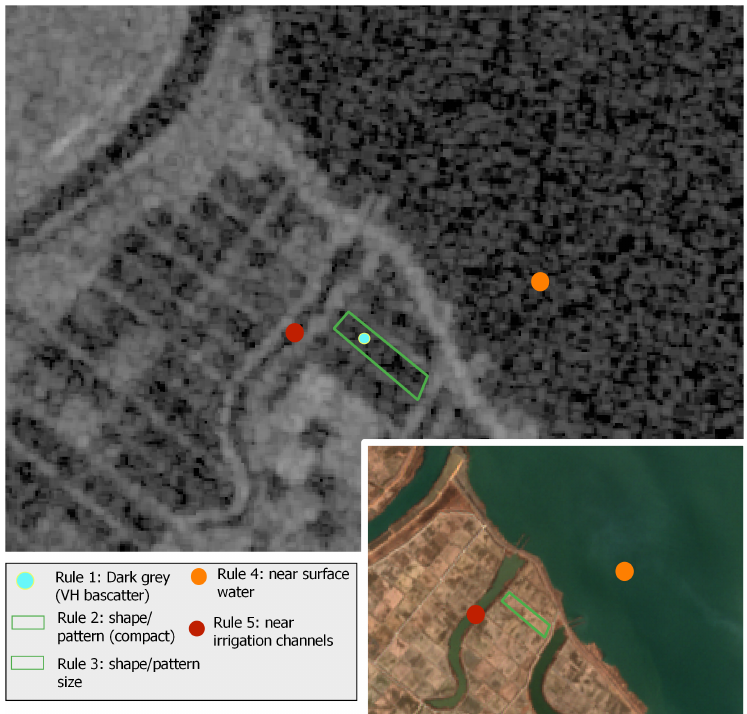
Figure 5. Example of the photo-interpretation rules used for creating the labeled dataset. The grayscale image is the VH backscatter for the 31 May 2018 Sentinel-1 acquisition and the colored image is the RGB for the 18 April 2018 Sentinel-2 acquisition. The latter is used for feature clarity.